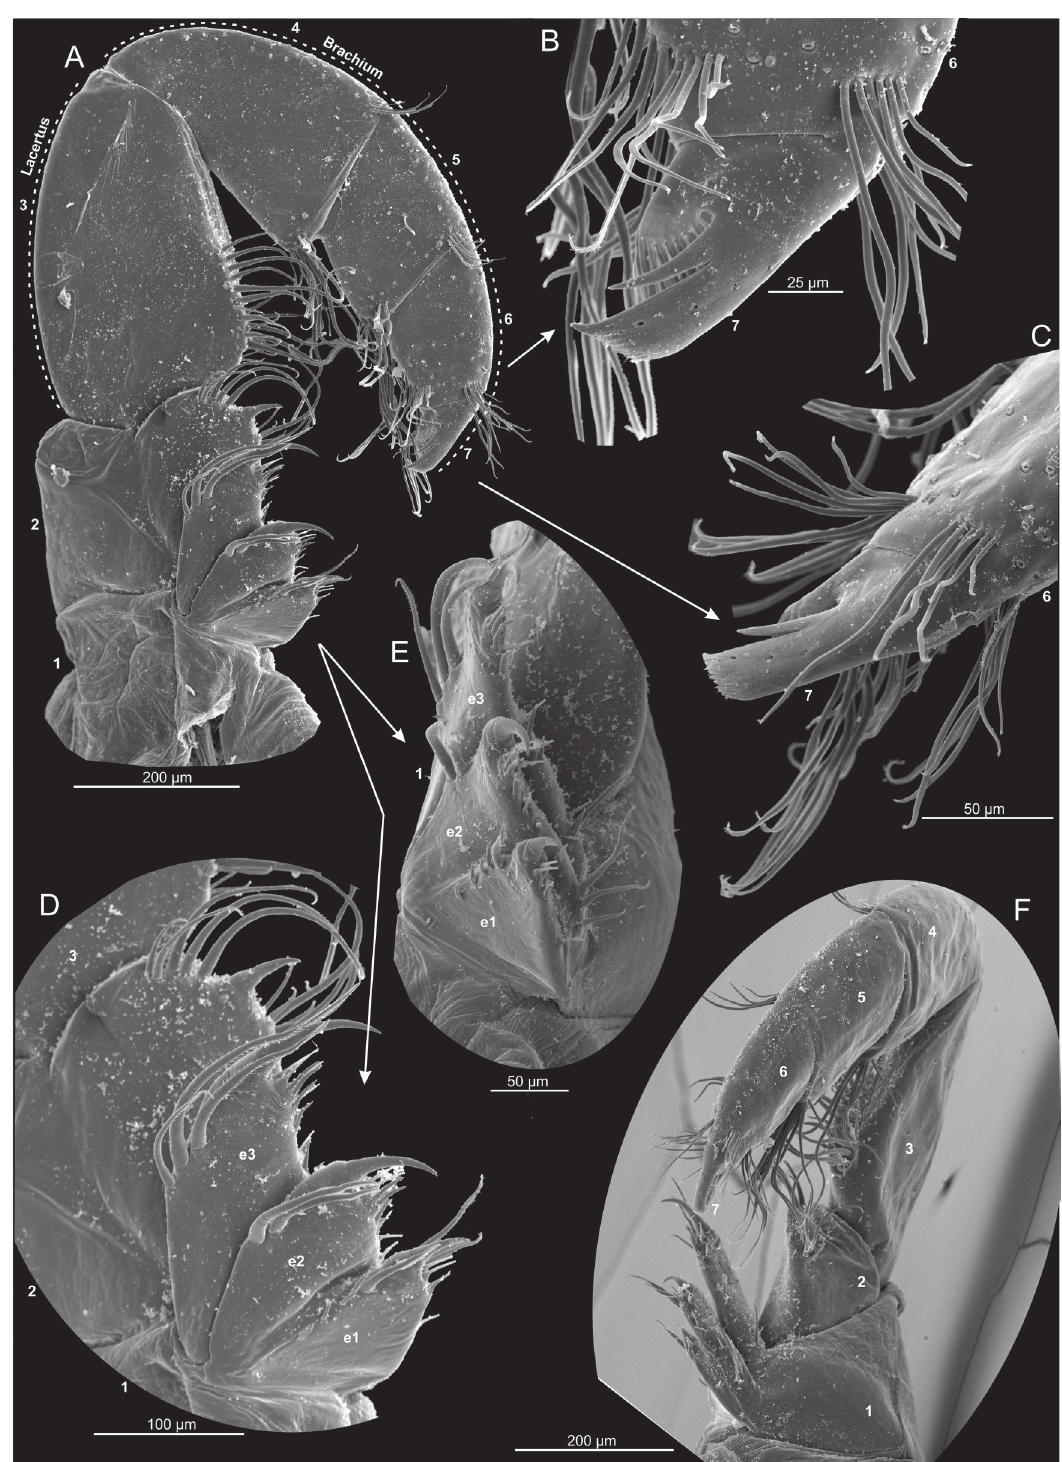
Fig. 7. Xibalbanus cozumelensis sp. nov., paratype (ZMUC-CRU-4792), maxilla 2 (mx2), left side, scanning electron microscopy. A . Complete mx2 from anterior. B . Close-up of terminal claw-complex from anterior (segment 7). C . Close-up of terminal claw-complex from lateral (segment 7). D . Median side of segments 1 and 2 with endites (e1–3) from anterior. E . Endites of segment 1 (e1–3) from median. F . Complete mx2 from